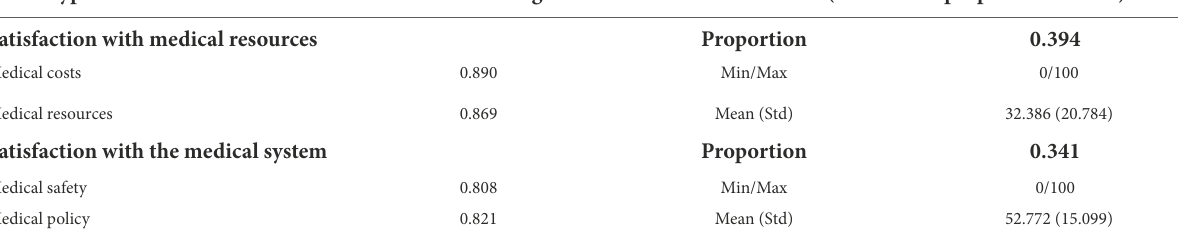
TABLE 2 Factor analysis of satisfaction with medical resources and system ( N = 3,207). Factor